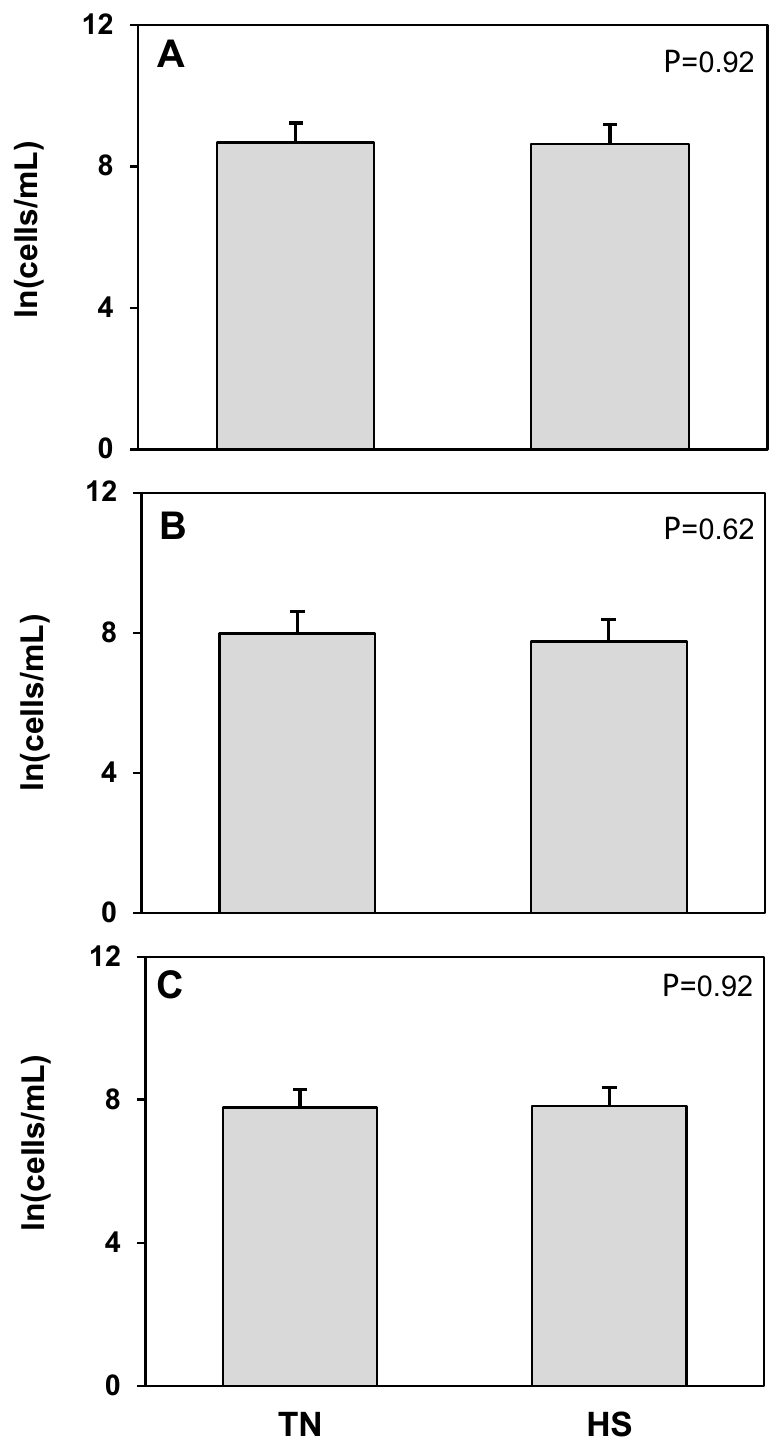
Figure 3. Heat stress (HS) impacts on lymphocytes (CD3 + CD45 + ) cell concentration in milk compared to thermoneutral (TN) conditions. ( A ) Total cells, ( B ) live cells (propidium iodide negative; PI − ), and ( C ) dead cells (propidium iodide positive; PI + ). Cell population data were natural log transformed for statistical analysis. Values presented are least square means of natural log transformed data with error bars presenting the SEM (n = 10).